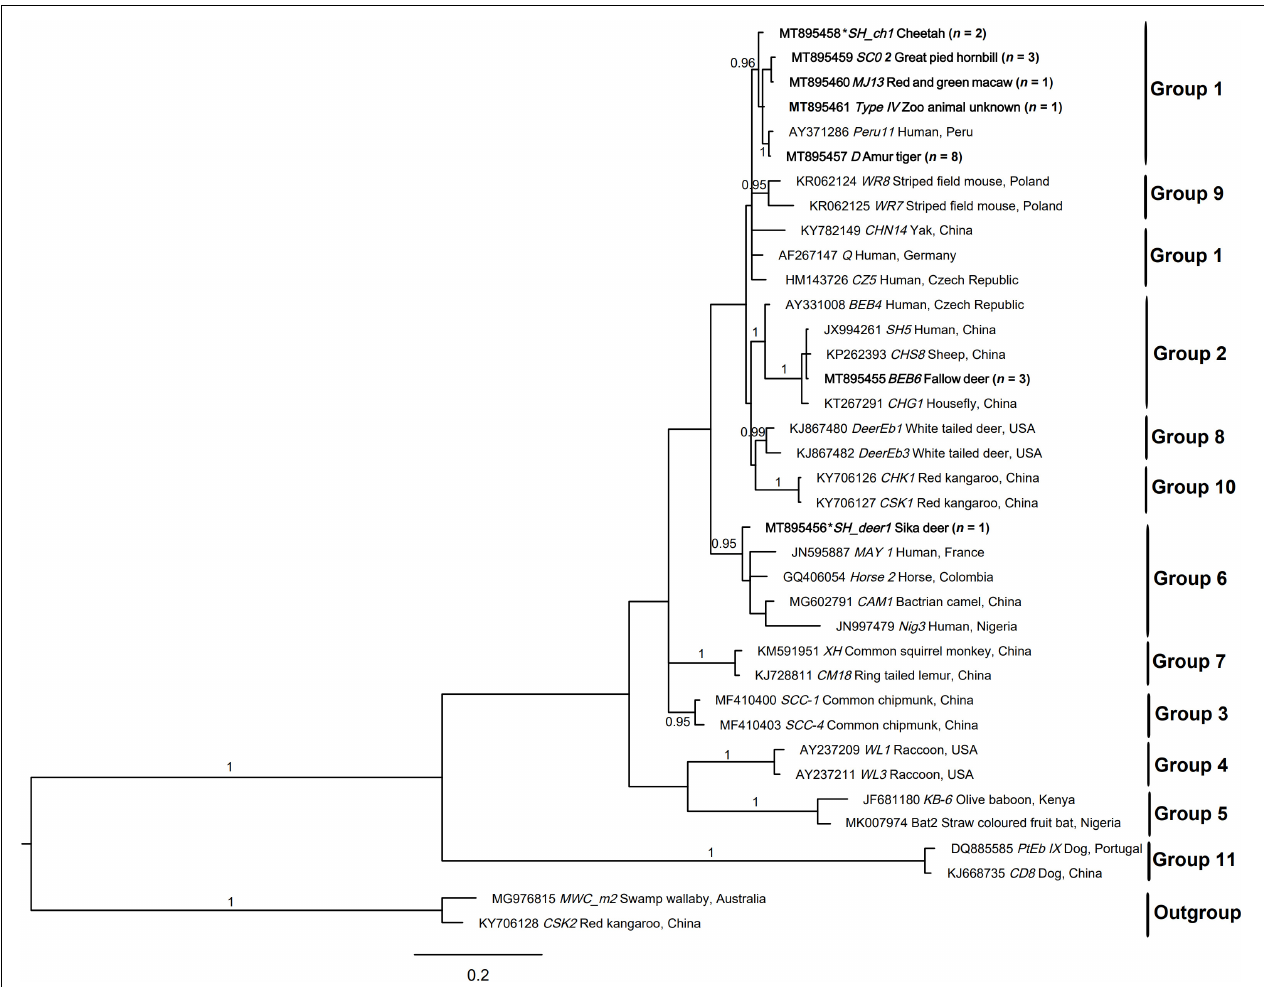
FIGURE 2 | Relationships among the genotypes of Enterocytozoon bieneusi recorded in the wildlife in this study inferred from the phylogenetic analysis of sequence data for the internal transcribed spacer (ITS) of nuclear ribosomal DNA by Bayesian inference (BI). Statistically significant posterior probabilities (pps) are indicated on branches. Individual GenBank accession numbers precede genotype designation (in italics) followed by sample and locality descriptions. The Enterocytozoon bieneusi genotypes identified and characterized from fecal DNA samples in the present study are indicated in bold type. Clades were assigned group names based on the classification system established by Karim et al. (2015) and Li et al. (2019a). The scale bar represents the number of substitutions per site. The E. bieneusi genotypes PtEbIX (DQ885585) and CD8 (KJ668735) from dogs were used as outgroups. All the groups were strongly supported ( pp = 0.96–1). pp < 0.95 were not